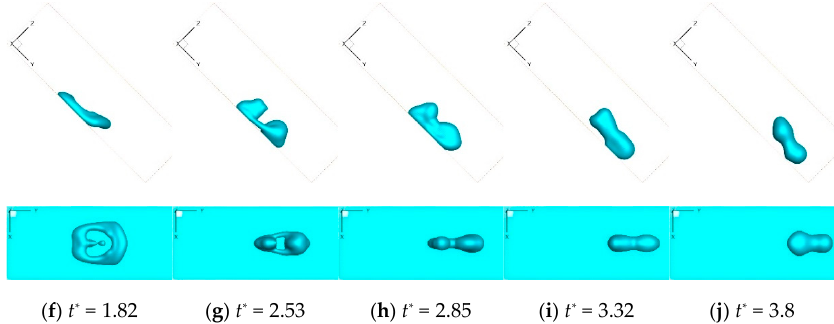
Figure 4. Snapshots of two successive droplets impacting an inclined superhydrophobic surface at v r = 1.5 and L z * = 1.18.